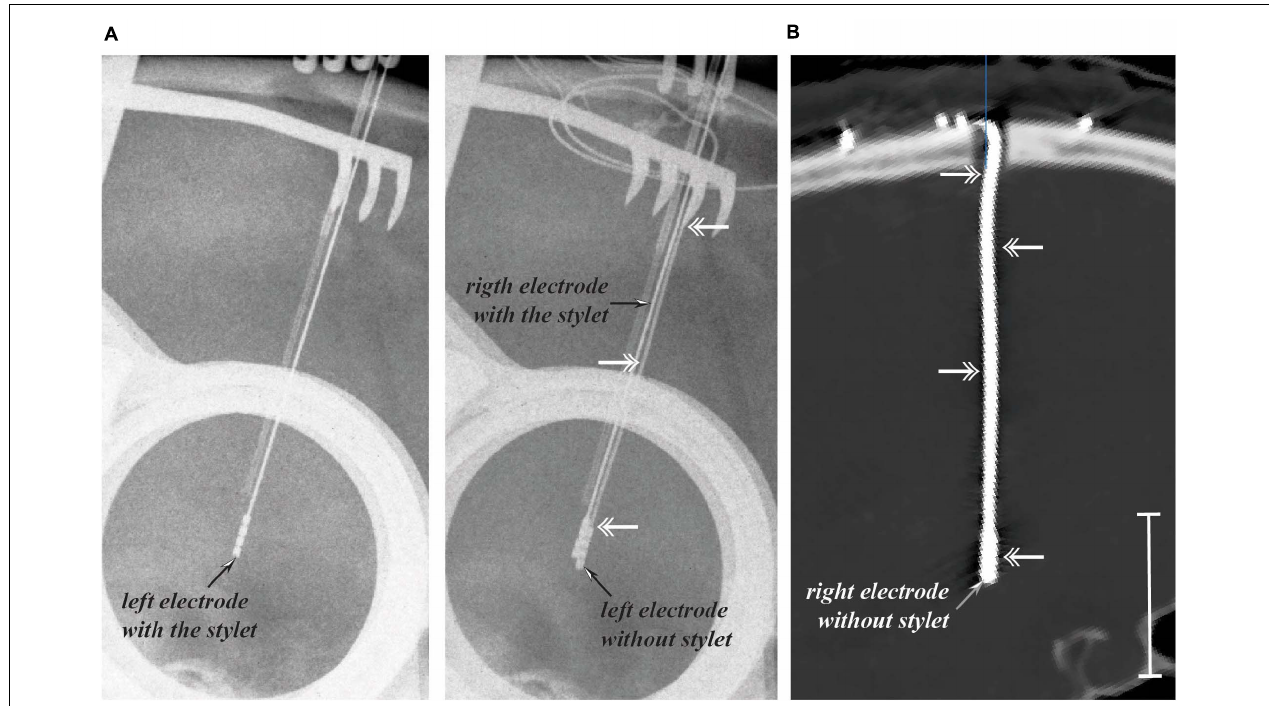
FIGURE 2 | Electrode deformation following stylet retraction. Intraoperative X-rays ( A ; lateral projection; anterior is on the right) showing the electrode deformation (double arrows) after removal of stylet (left and intermediate rows) and immediately after removal of the stereotactic frame on postoperative CT scan ( B ; pseudo sagittal reconstructed slice along the right electrode; anterior is on the right; white vertical bar = 25 mm).